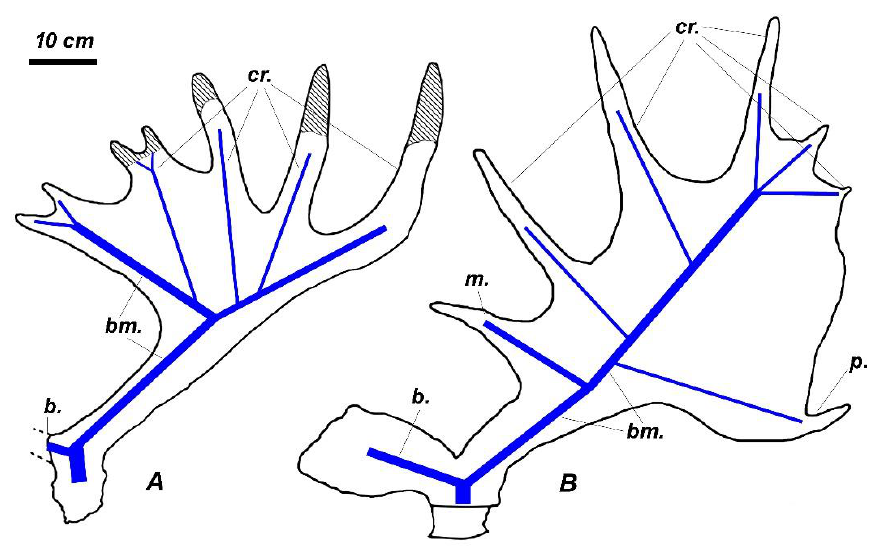
Figure 12. Comparison of antler bauplan in Sinomegaceros stavropolensis ( A ) and Megaloceros giganteus antecedens ( B ).